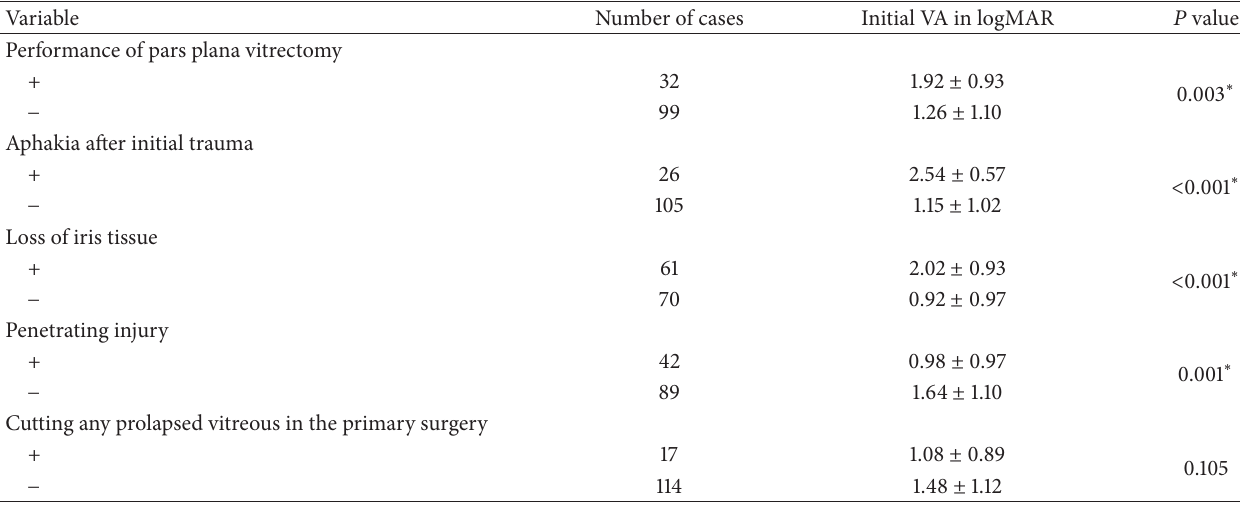
Table 6: The comparisons of the final visual outcomes among cases with and without the significant independent variables after the backward stepwise